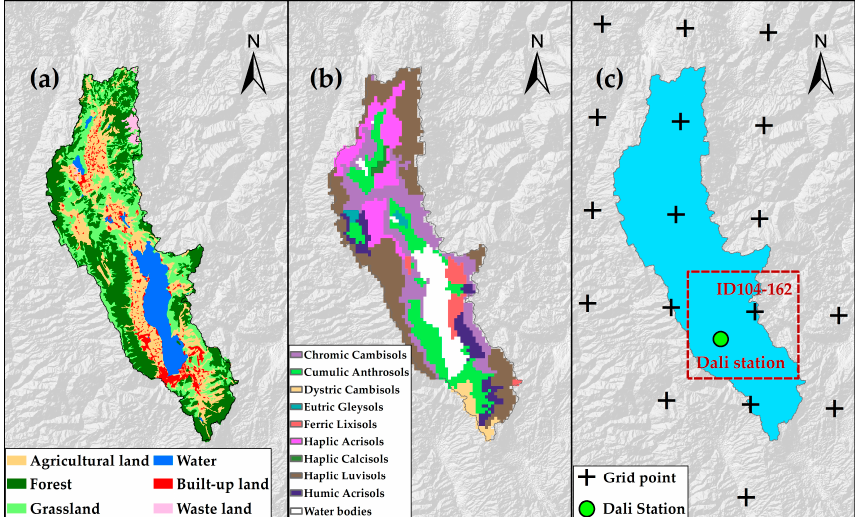
Figure 3. The land use map ( a ), soil type map ( b ) and China Meteorological Assimilation Driving Datasets (CMADS) grid points in the ELB ( c ).